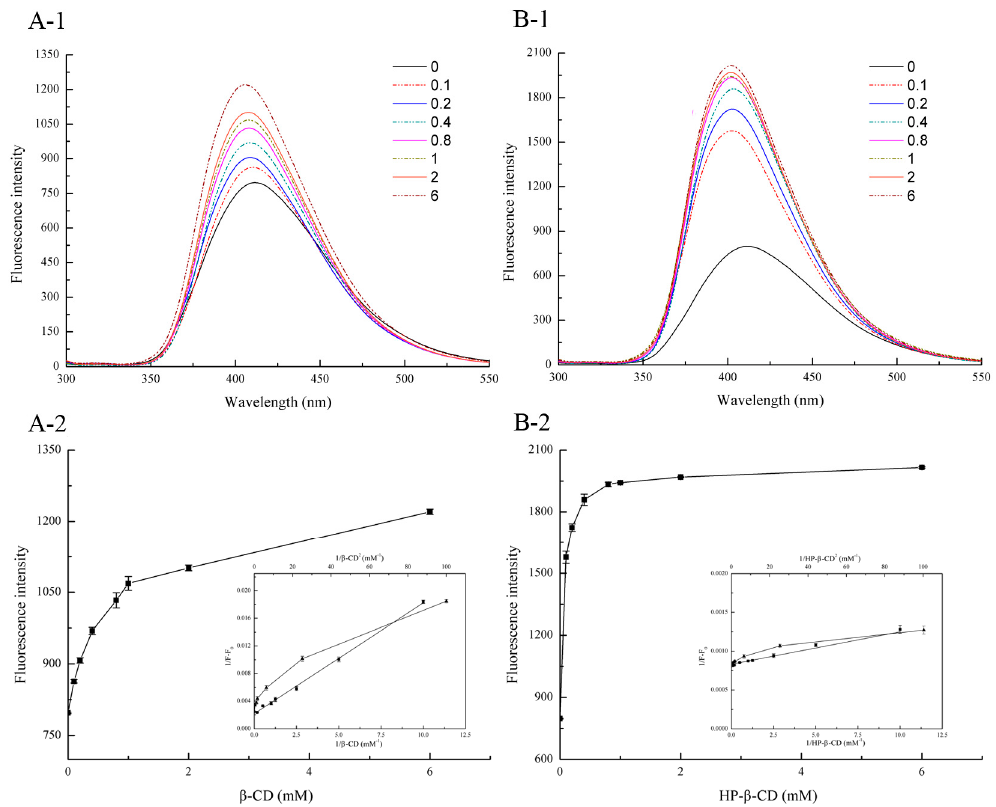
Figure 2. Differential fluorescence emission spectrums of oxyresveratrol/ β -CD ( A-1 ) and oxyresveratrol/HP- β -CD ( B-1 ) inclusion complexes against oxyresveratrol at the same concentration (100 µ M). 0 → 6 mean the concentration of cyclodextrin at 0, 0.1 mM, 0.2 mM, 0.4 mM, 0.8 mM, 1.0 mM, 2.0 mM and 6.0 mM. Dependence of emission fluresence intensities of oxyresveratrol on varies β -CD ( A-2 ) and HP- β -CD ( B-2 ) concentrations. Inset: double reciprocal plot of oxyresveratrol complexed to cyclodextrins for determining the stoichiometry of oxyresveratrol/CD conplexes: 1/(F ∞ − F 0 ) versus 1/[CD] (assumption of 1:1 complex) (filled squares); 1/(F ∞ − F 0 ) versus 1/[CD] 2 (assumption of 1:2 complex) (filled triangles).